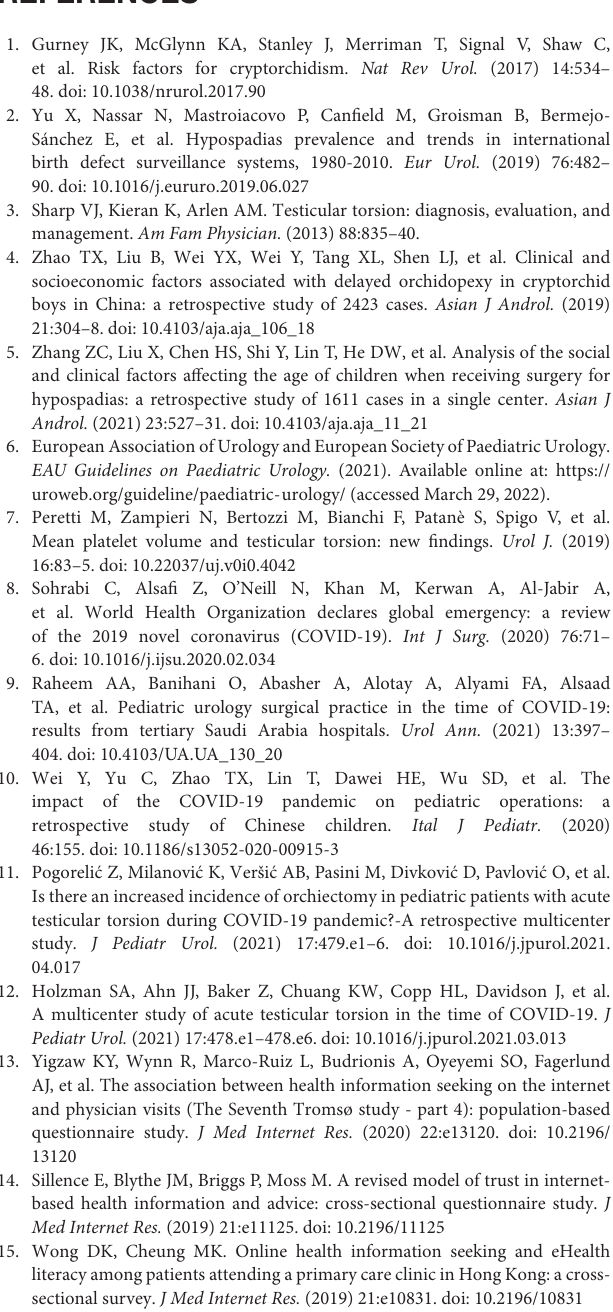
an included video with the source and quality assessment based on the titles in the image. Red or blue represent assessment by DISCERN or JAMA benchmark criteria. Different levels of color represent different single question scores or total scores. Supplementary Table 1 | DISCERN scoring system. Supplementary Table 2 | JAMA benchmark criteria. Supplementary Table 3 | Hexagonal charting